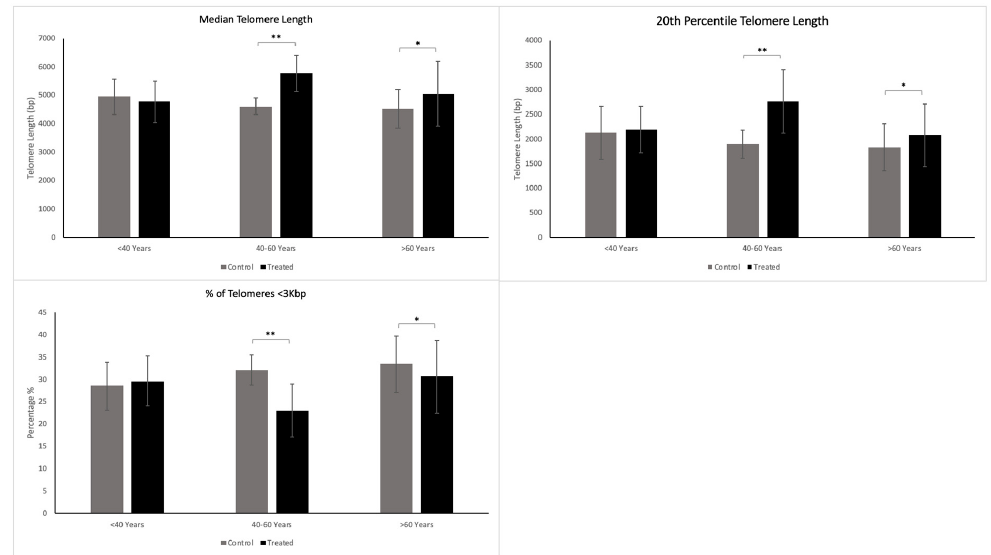
Figure 3. Bar chart age group comparison of control vs. treated according to median telomere length, 20th percentile telomere length, and the % of telomeres <3 Kbp. Significant differences are indicated: *— p < 0.05; **— p < 0.01).